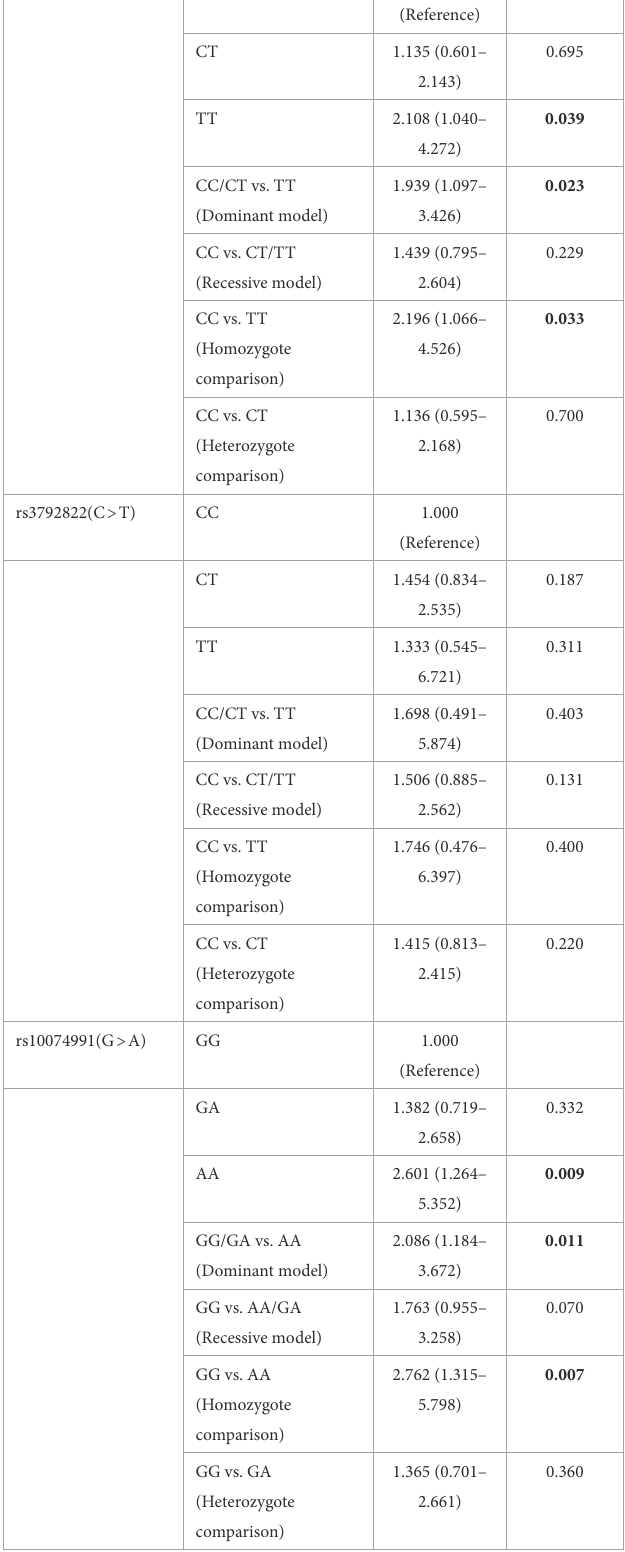
Data were analyzed via binary logistic regression. AOR, adjusted odds ratio (adjusted for age, gender and BMI); 95%CI, 95% confidence interval. P A adjusted for age, gender and BMI, Significant results (value of p < 0.05) were shown in bold